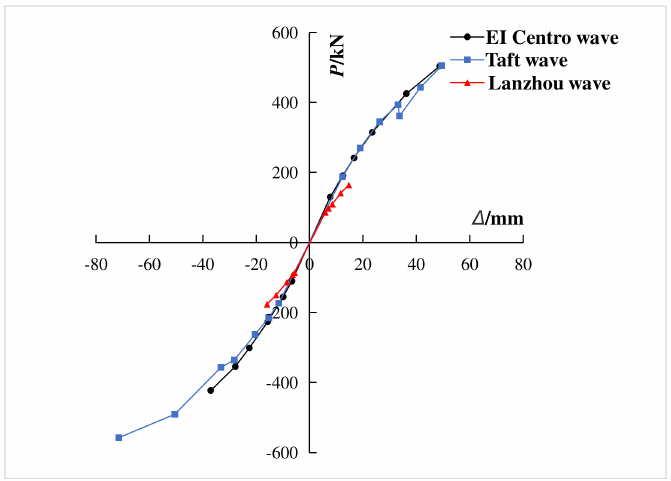
Figure 15. Skeleton curve of composite